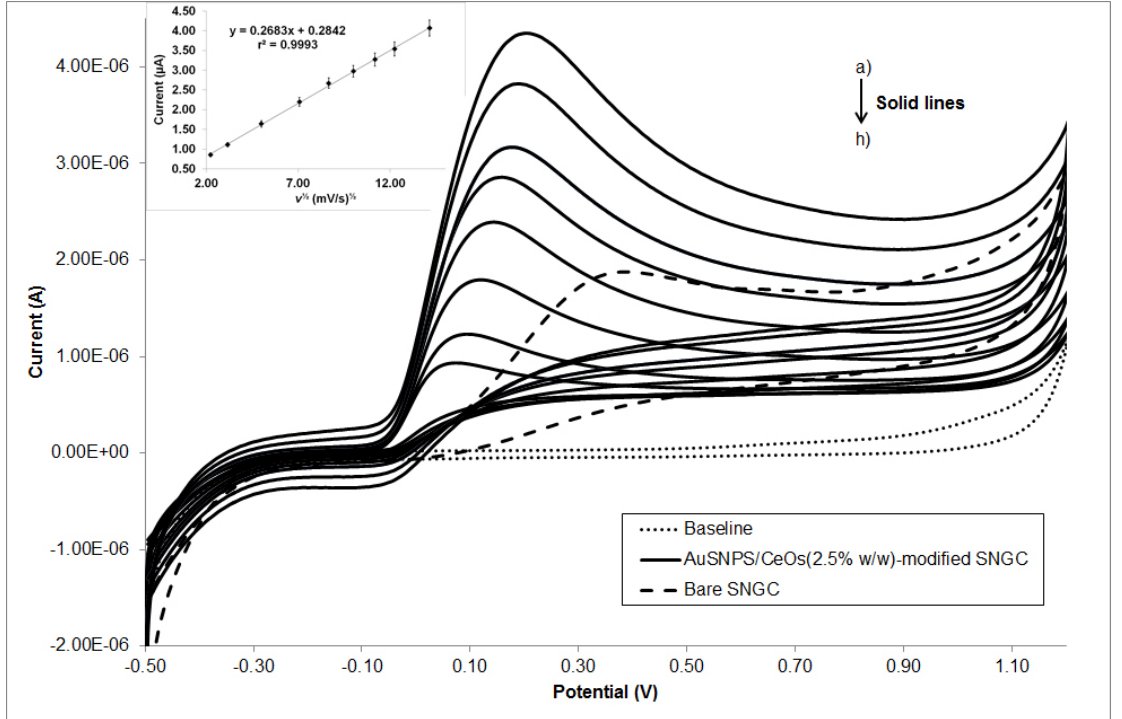
Figure 5. CV voltammograms of 1.0 mM AA, in 0.10 M PBS (pH 6.9) at AuSNPs/CeO (2.5% w/w)-modified SNGC electrode (solid lines) at different scan rates: ( a ) 5; ( b ) 10; ( c ) 25; ( d ) 50; ( e ) 75; ( f ) 100; ( g ) 150; ( h ) 200 mV·s − 1 ), and at bare SNGC electrode (dashed line) at 50 mV·s − 1 . The inset displays the plot of peak current against square root of scan